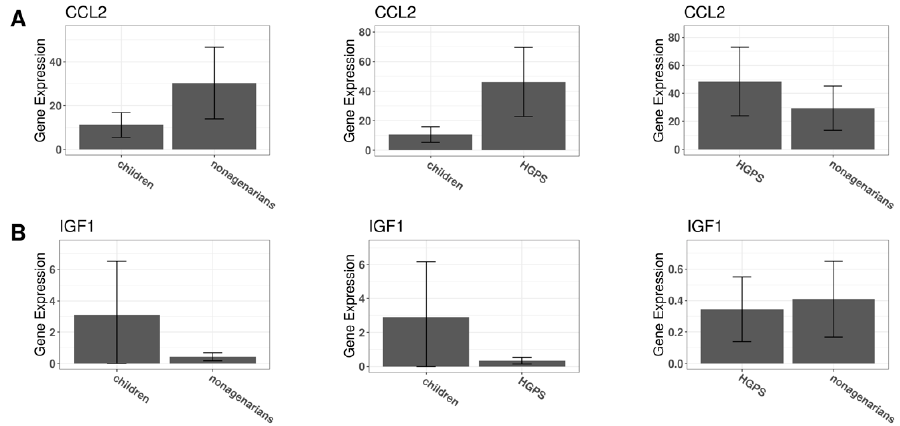
Figure 12. NicheNet analyses of progeria and aging. ( A ) Expression of CCL2 in children and nonagenarians, children and progeria patients, and progeria patients and nonagenarians. ( B ) Expression of IGF1 in children and nonagenarians, children and progeria patients, and progeria patients and nonagenarians.